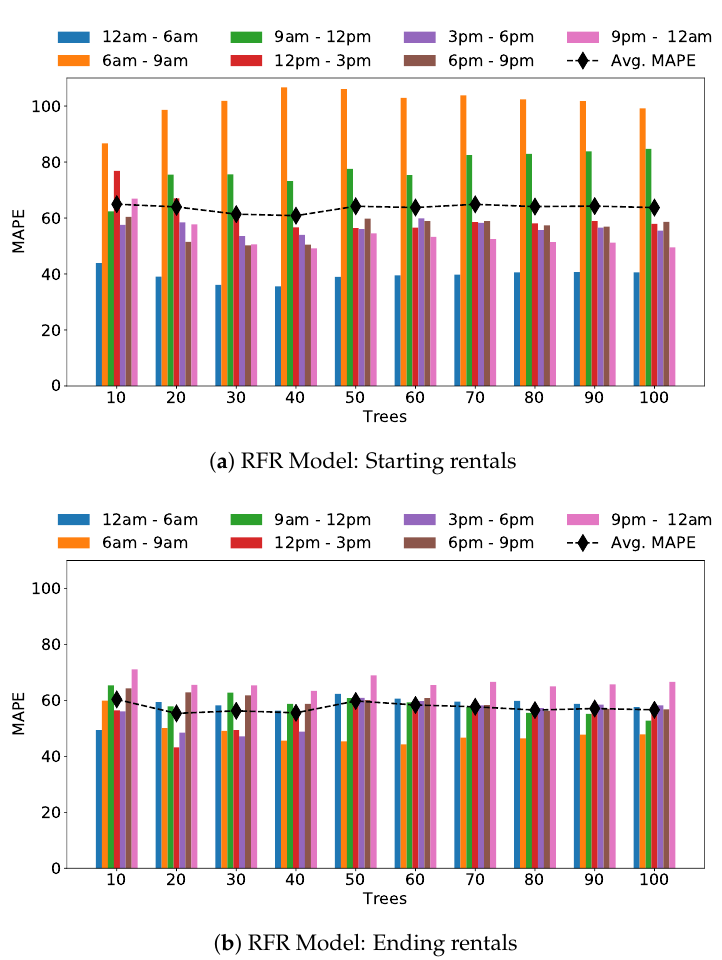
Figure 11. Spatial prediction—MAPE for Random Forests Regression models, using different number of